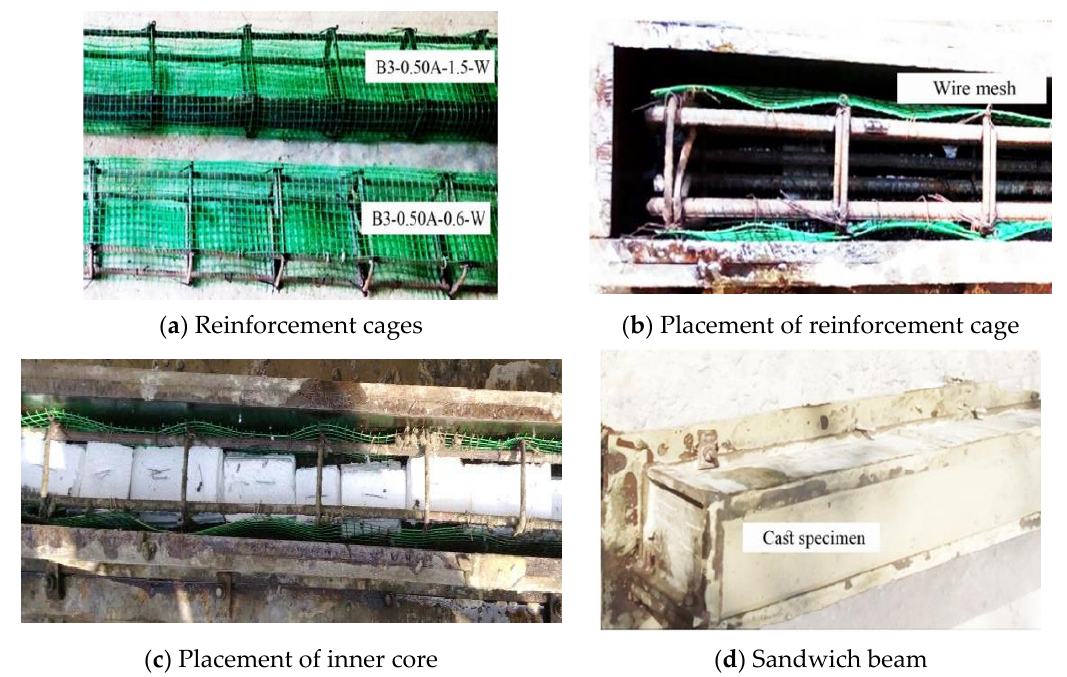
Figure 1. Fabrication sequences of sandwich beams: ( a ) Stage-I, ( b ) Stage-II, ( c ) Stage-III, and ( d ) Stage-IV. Table 1. Designation of sandwich